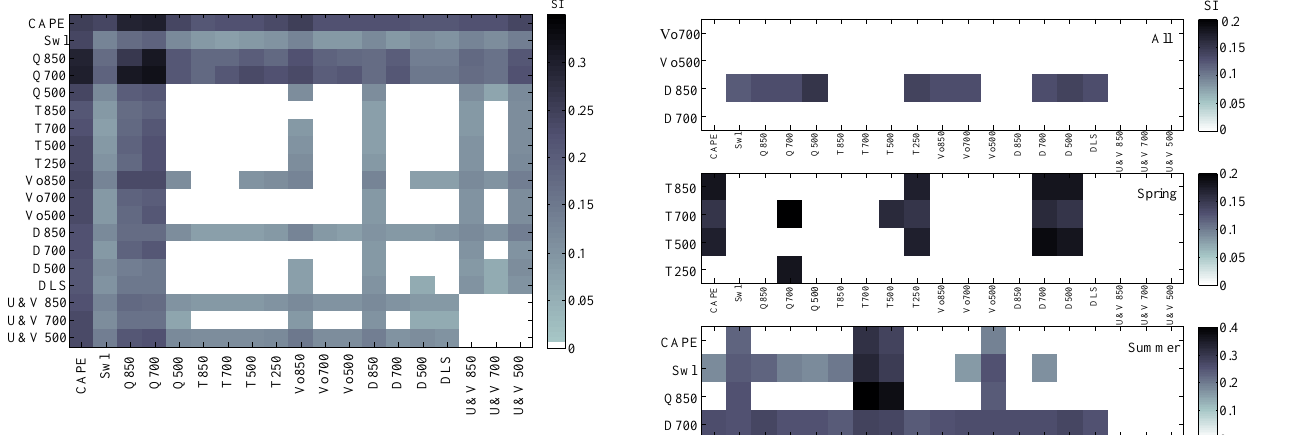
Figure 4. The SI value for each pair of atmospheric indicators in Table 2 for local convection events using daily values. Any value that was not significant at p =0.05 level was given a value of zero.